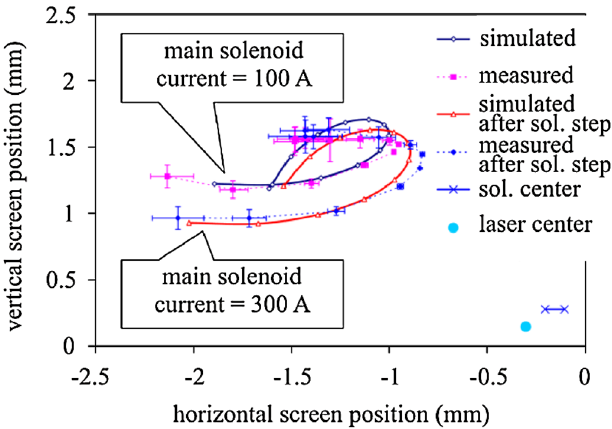
FIG. 22. (Color) Main solenoid BBA: movement of the electron beam center position ( x , y ) with a variation of the main solenoid current. Error bars on the plot correspond to the electron beam position jitter at the